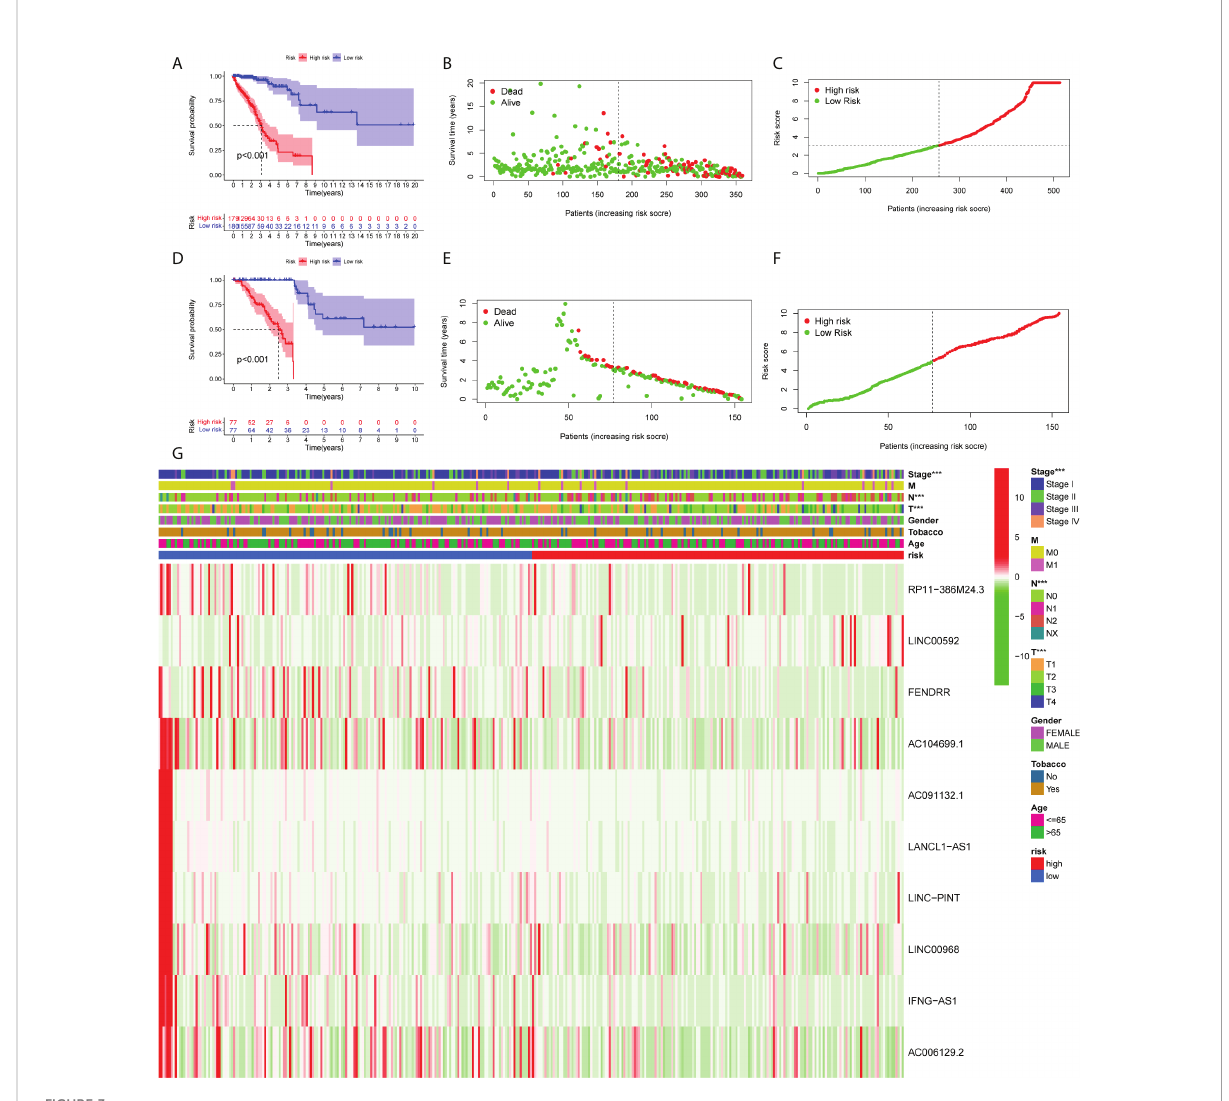
FIGURE 3 Development and validation of the prognostic ferroptosis-associated long non-coding RNA signature. (A, D) Kaplan-Meier curve, (B, E) risk score, (C, F) survival status and (G) heatmap are shown. ***means